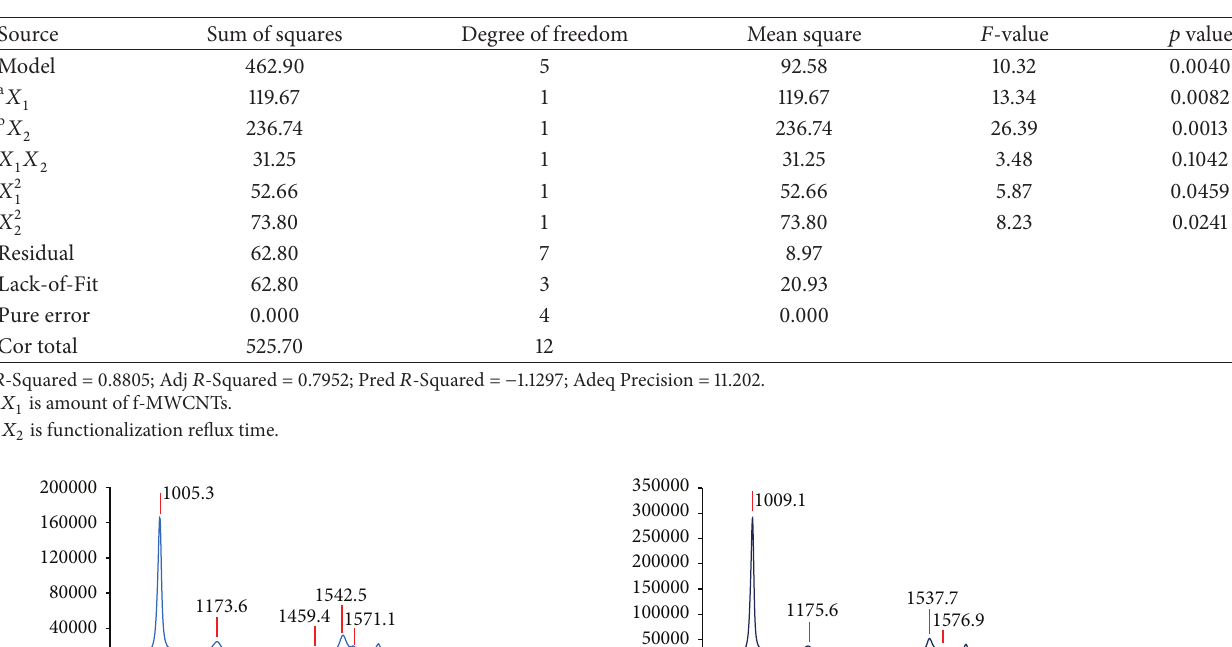
Table 5: Analysis of variance for NUE using CCD.